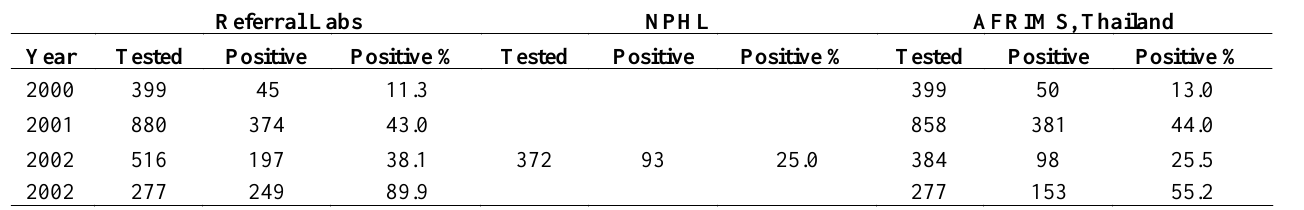
Table I : Laboratory Diagnosis (QA), 2000-2003 Referral Laboratories: NPHL (Teku), VBDRTC (Hetauda), BPKIHS (Dharan), BHZH